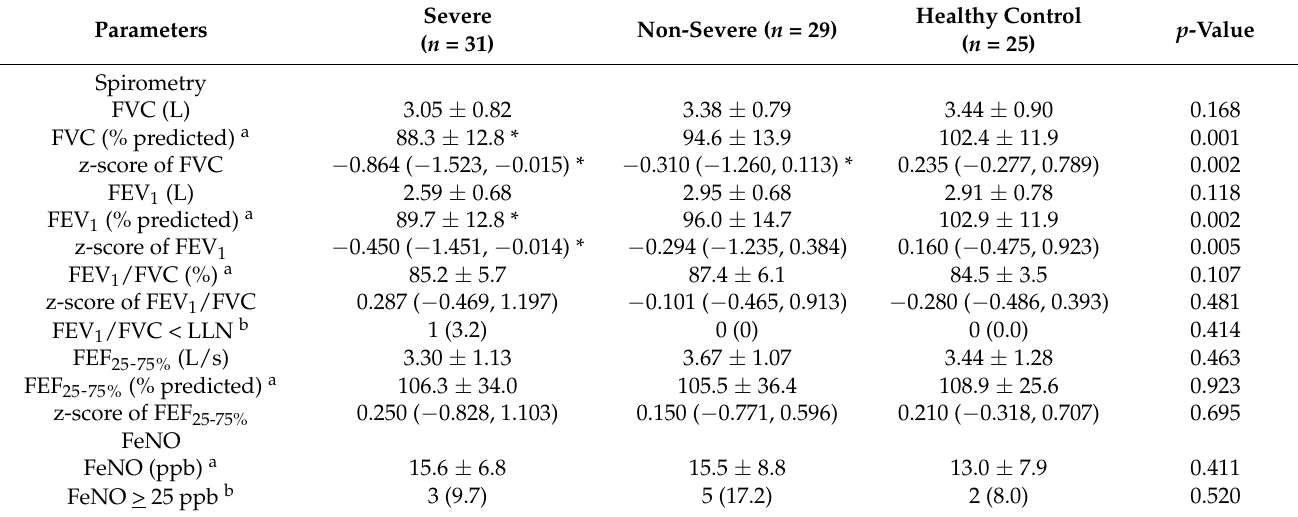
Table 6. Spirometry and FeNO at one-month follow-up visit ( n = 85).